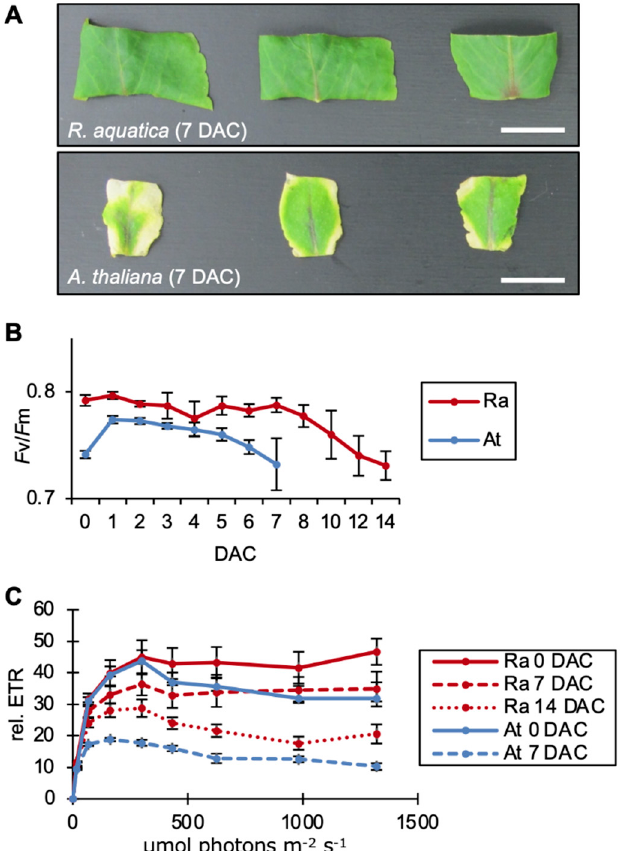
Figure 1. Comparison of the viability of R. aquatica (Ra) and A. thaliana (At) leaf fragments. ( A ) Leaf explants of R. aquatica and A. thaliana 7 days after cutting (DAC). Scale bars = 1 cm. ( B ) Time-course measurements of maximum quantum efficiency of photosystem II ( F v/ F m). Vertical line and horizonal line indicate F v/ F m and time points, respectively. ( C ) Time-course measurements of light-intensity dependent electron transport rate (ETR). Vertical line and horizonal line indicate relative photosynthetic electron transport rate (rel. ETR) and time points, respectively. As A. thaliana explants cultured for more than seven days could not be assessed, measurements were only recorded from 0 to 7 days in A. thaliana leaf explants. Dotted and solid lines indicate the expression levels at the distal and proximal sides, respectively. Data are presented as mean ± standard error (SE) ( n = 5).